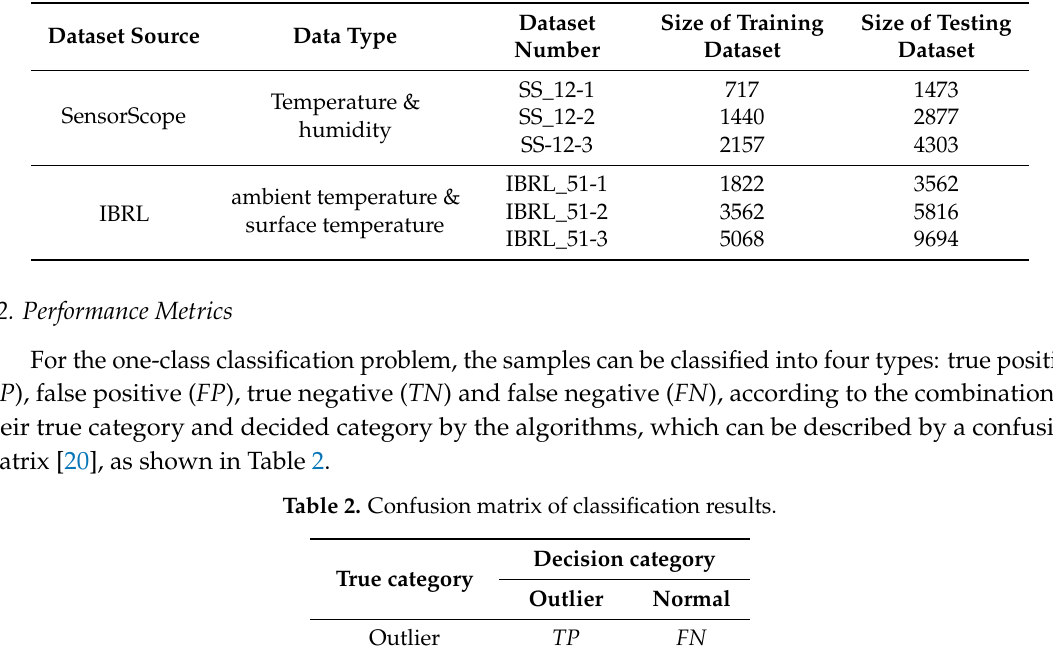
Table 1. Experimental datasets.